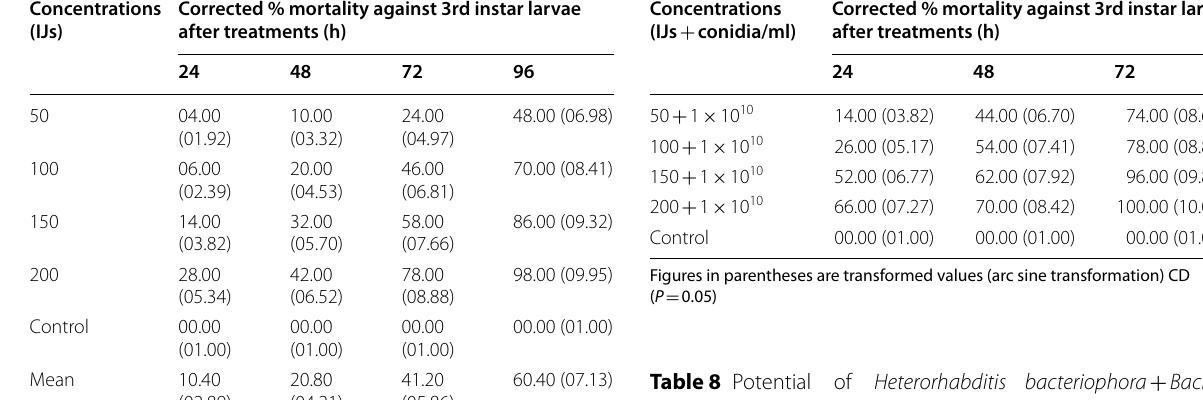
Table 4 Pathogenic potential of Heterorhabditis bacteriophora against 3rd instar larvae of Spodoptera litura under laboratory conditions